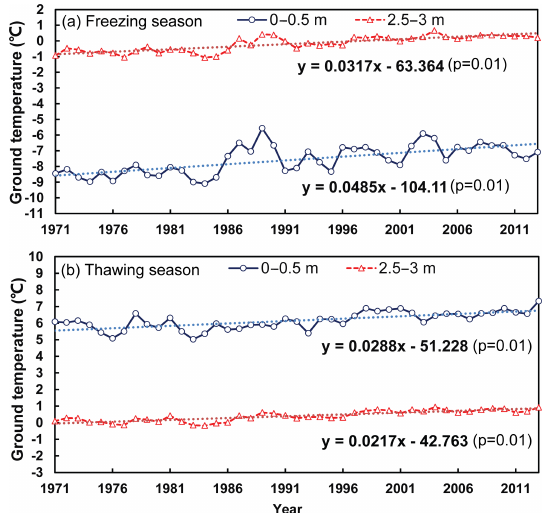
Figure 7. Simulated ground temperature changes in (a) the freezing season (from November to March) and (b) the thawing season (from April to October). Results from linear regressions are indicated.